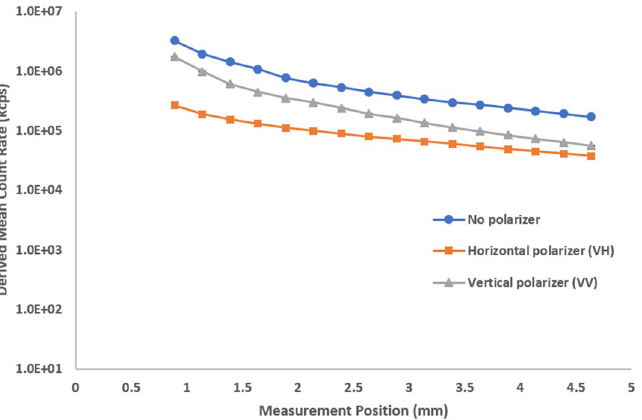
Figure 3. Derived count rate as a function of measurement position at different polarizer configurations for stock milk. The influence of multiple scattering increases further into the sample, away from the cuvette wall, leading to an apparent decrease in scattering intensity.